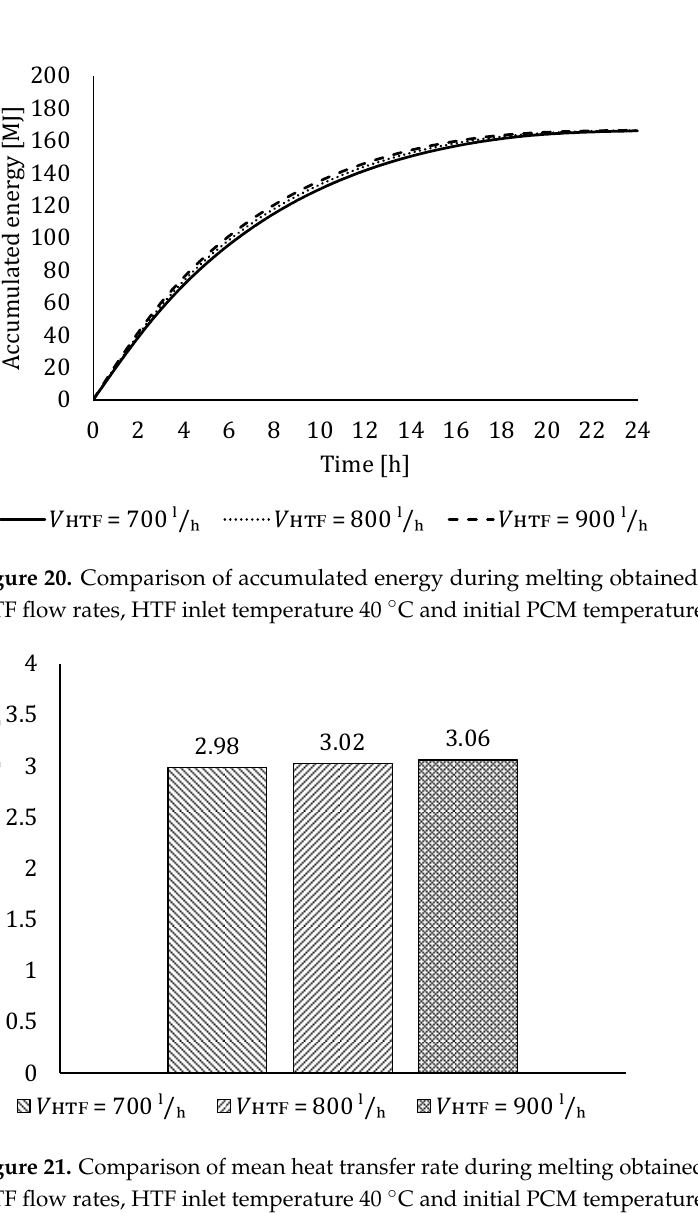
Figure 21. Comparison of mean heat transfer rate during melting obtained numerically for different HTF flow rates, HTF inlet temperature 40 °C and initial PCM temperature 15 °C.